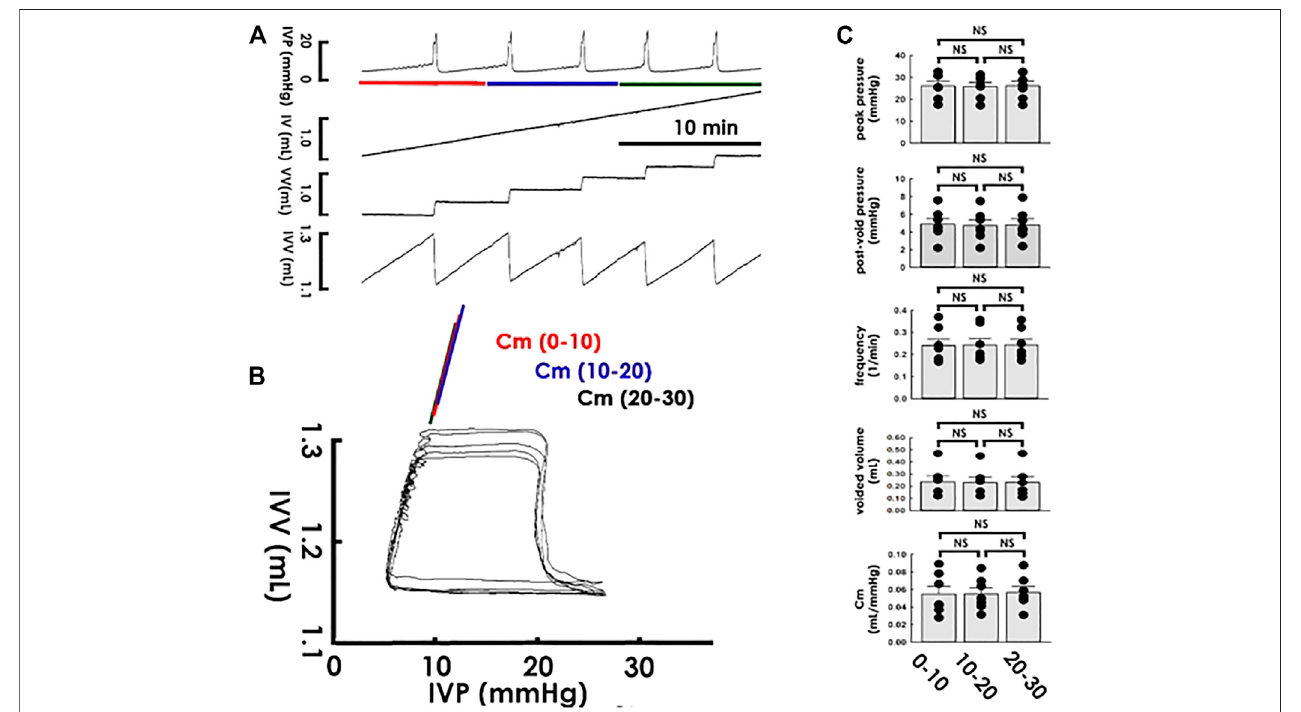
FIGURE 2 | Cystometry and pressure-volume analysis of rhythmic voiding contractions. (A) Cystometry showing regular voiding contractions with a constant frequencyataperiod of30 min.Red, blue,andgreenbars atthebottomofIVPmarkthecyclesdisplayed inthepressure-volumeanalysis. (B) Pressure-volume analysis showing overlapped loops. The mean compliance (Cm) of loops at the fi rst (0 – 10; red), second (10 – 20; blue), and last (20 – 30; green) 10 min are well-coincident. (C) No statistical difference is evidenced in the peak pressure, post-void pressure, voiding frequency, voided volume, and Cm between contractions of the fi rst, second, and last 10 min of the recording period. IVP, intra-vesical pressure; IV, infused volume; VV, voided volume; IVV, intra-vesical